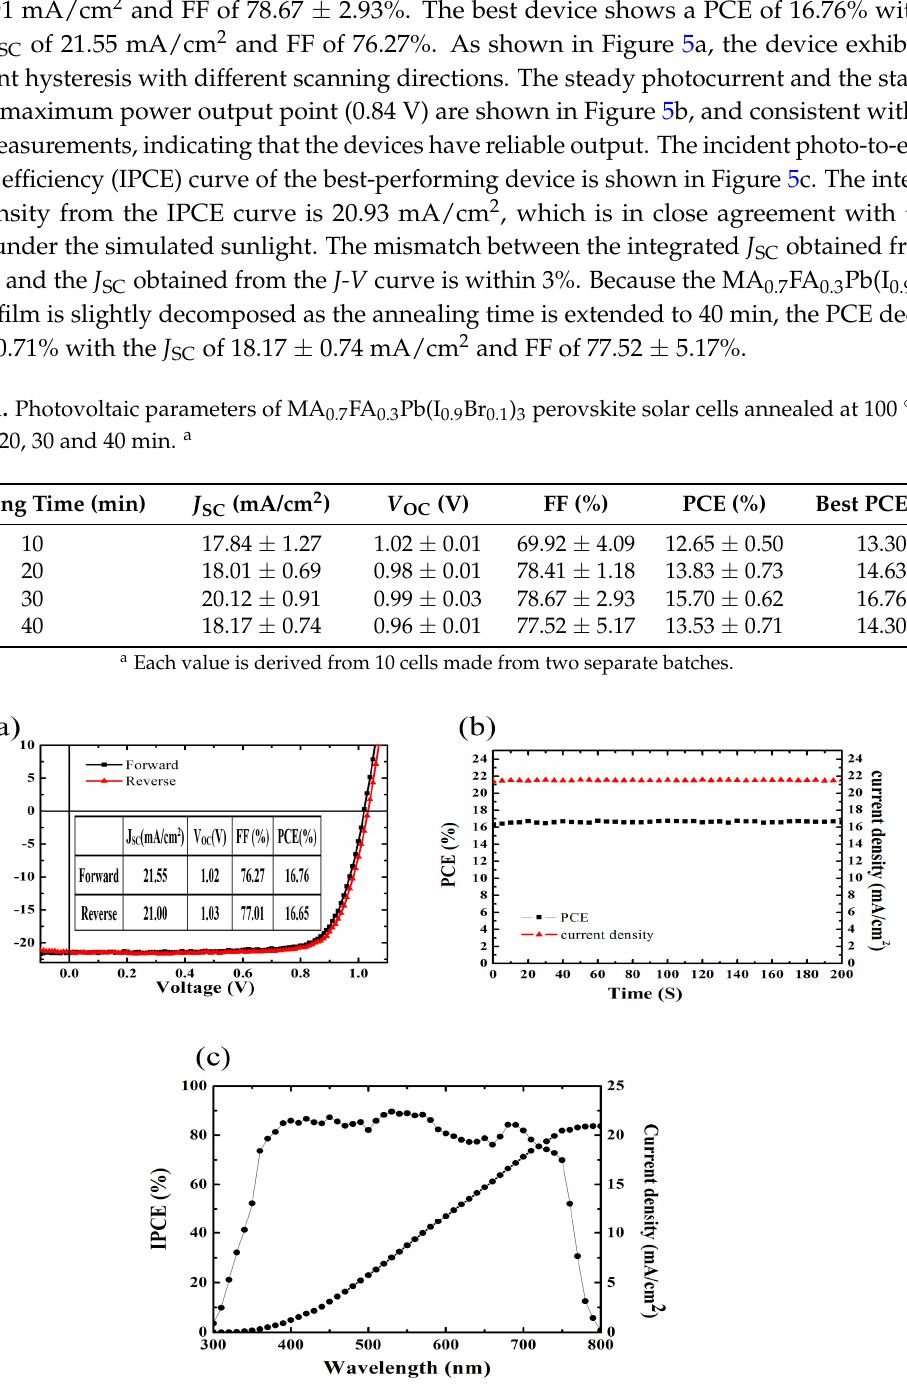
Figure 5. ( a ) J - V characteristics of forward and reverse bias sweeps for the best-performing MA 0.7 FA 0.3 Pb(I 0.9 Br 0.1 ) 3 PSC annealed at 100 °C for 30 min; ( b ) Steady measurement at the maximum MA 0.7 FA 0.3 Pb(I 0.9 Br 0.1 ) 3 PSC annealed at 100 ◦ C for 30 min; ( b ) Steady measurement at the maximum power output point; ( c ) IPCE spectrum of the best-performing solar cell. power output point; ( c ) IPCE spectrum of the best-performing solar